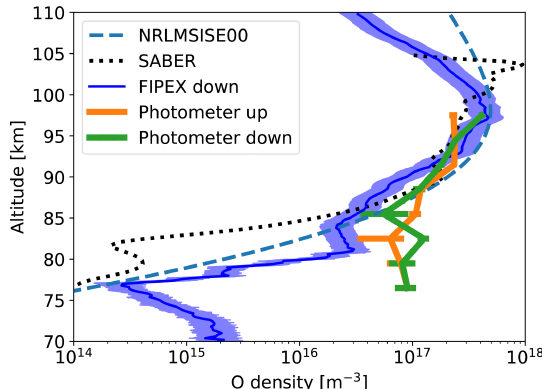
Figure 9. Atomic oxygen density measurements. Bold orange and green lines with error bars show photometer measurements on the upleg and downleg, respectively. FIPEX downleg data are shown by the blue profile, with the shaded area showing measurement errors. The black dotted line shows SABER measurements (Level 2A, O event 20, orbit 71729). The blue dashed line shows NRLMSISE-00 model data for the time of the rocket